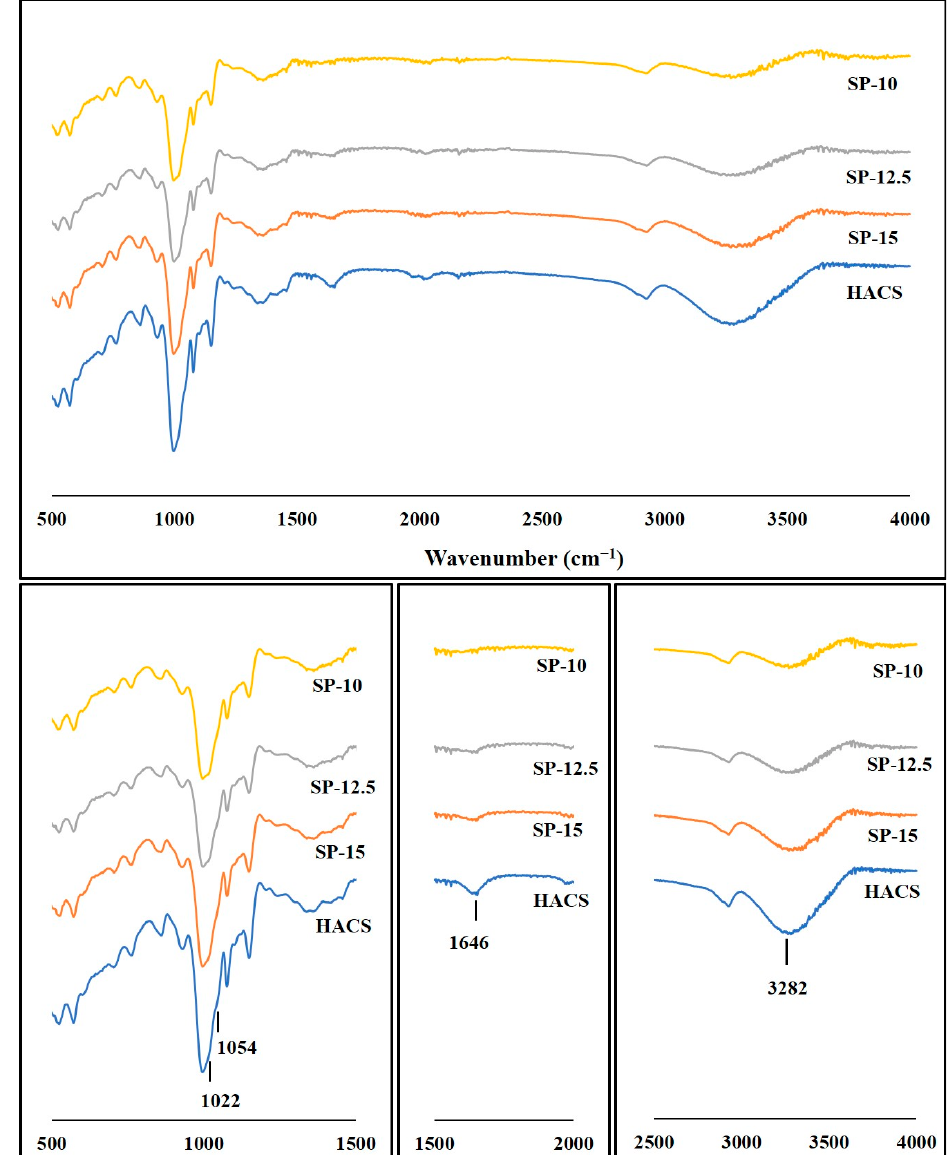
Figure 6. ATR-FTIR spectra of the HACS and 3D-printed starch